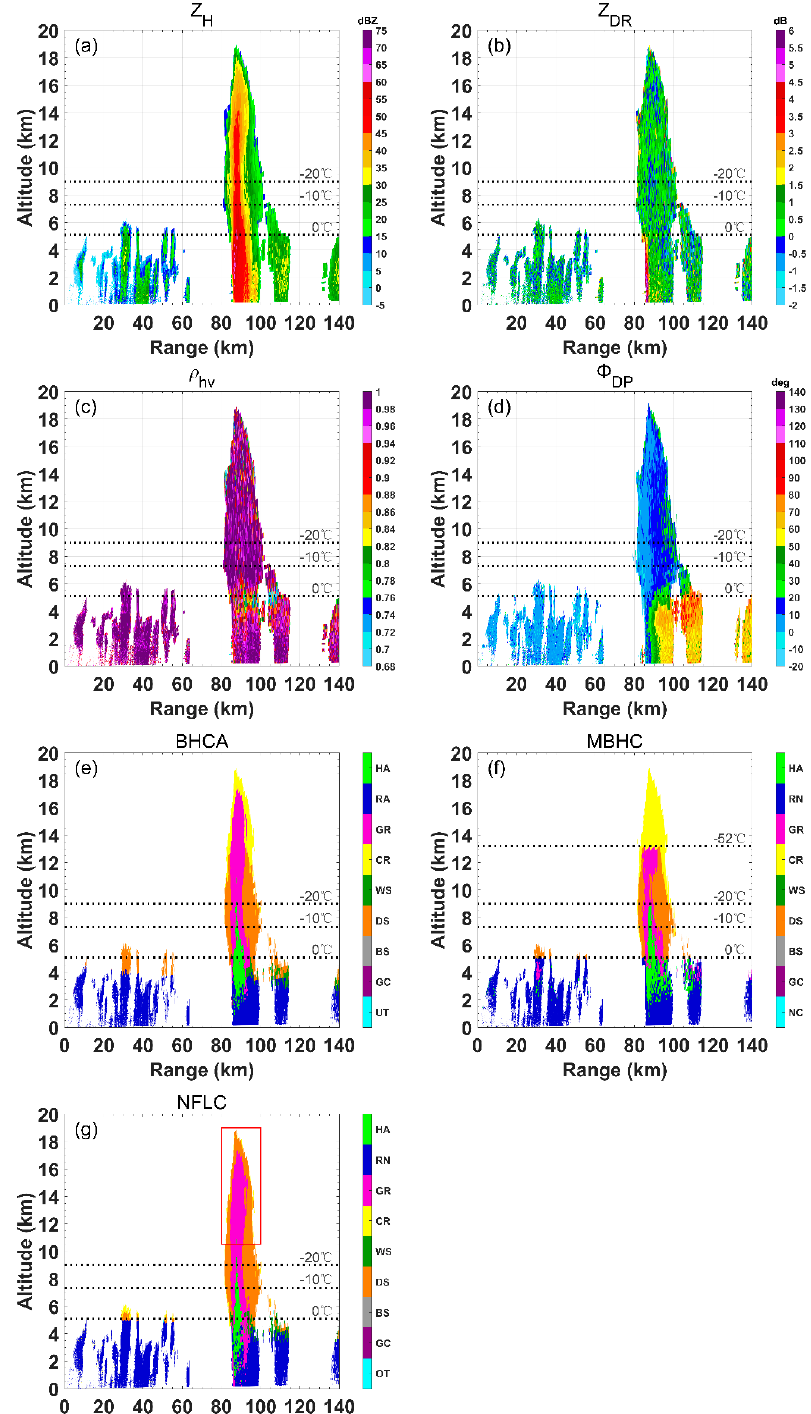
Figure 5. Range-height indicator (RHI) of ( a ) Z H , ( b ) Z DR , ( c ) ρ hv , ( d ) Φ DP , and corresponding hydrometeor classification results by the ( e ) Bayesian hydrometeor classification algorithm (BHCA), ( f ) Marzano-Bayesian hydrometeor classification algorithm (MBHC) and ( g ) NCAR fuzzy logic classifier (NFLC) at 128.6 ° azimuth, at 20:19 LST on 11 July 2014. The black dashed lines indicate the temperature level of 0 ℃ , − 10 ℃ and − 20 ℃ from bottom to top, respectively. The red rectangle highlights the differences in the classification results.